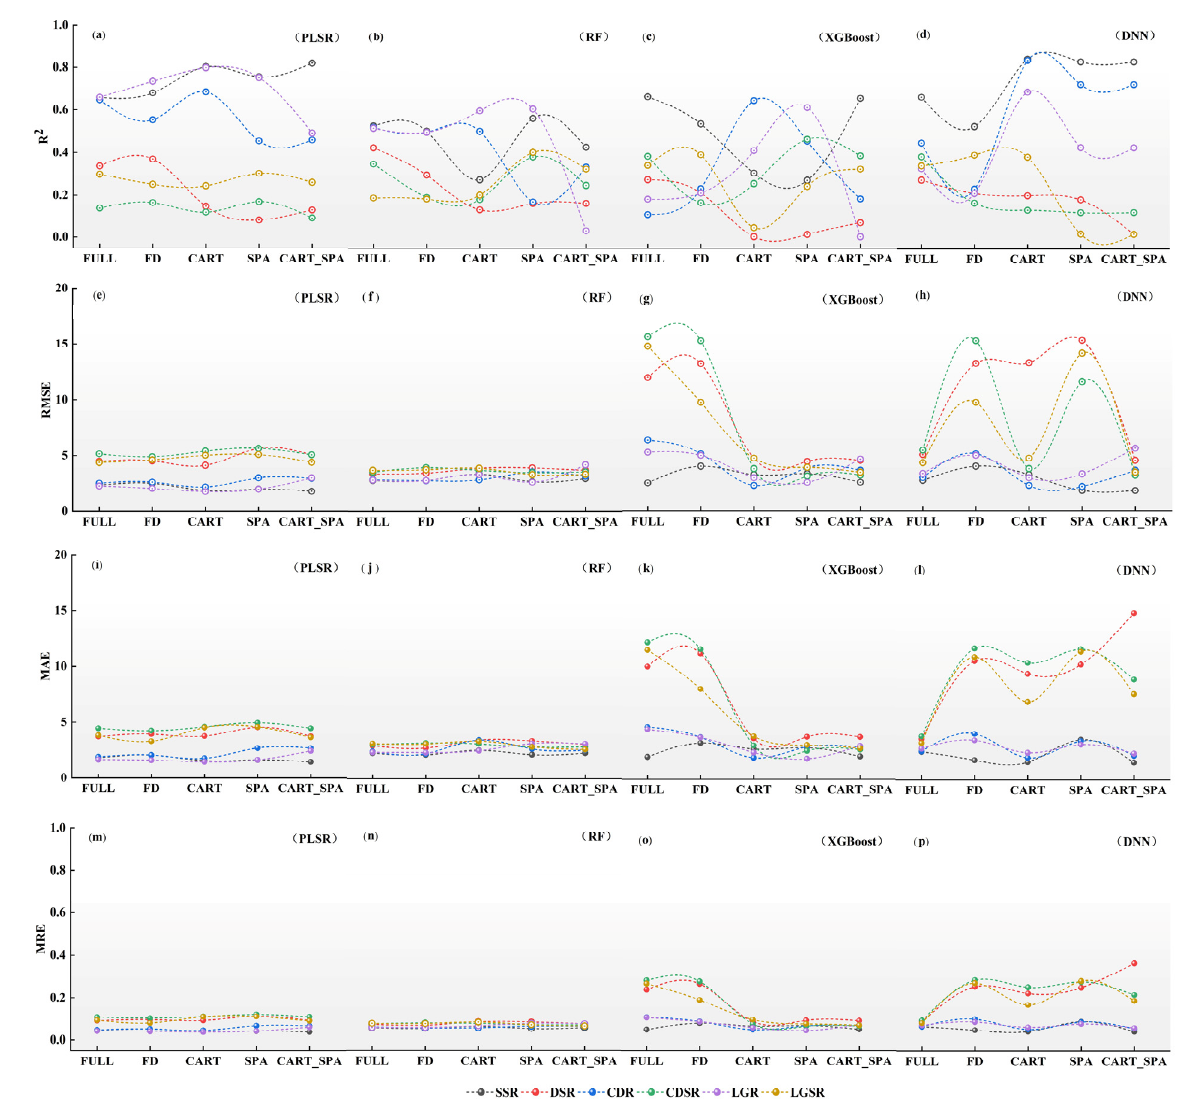
Figure 13. Comparison of SPAD values estimation accuracy for summer maize using UAV data and four ML models: ( a – d ) R 2 , ( e – h ) root mean square error ( RMSE ), ( i – l ) mean absolute error ( MAE ), ( m – p ) mean relative error ( MRE ).